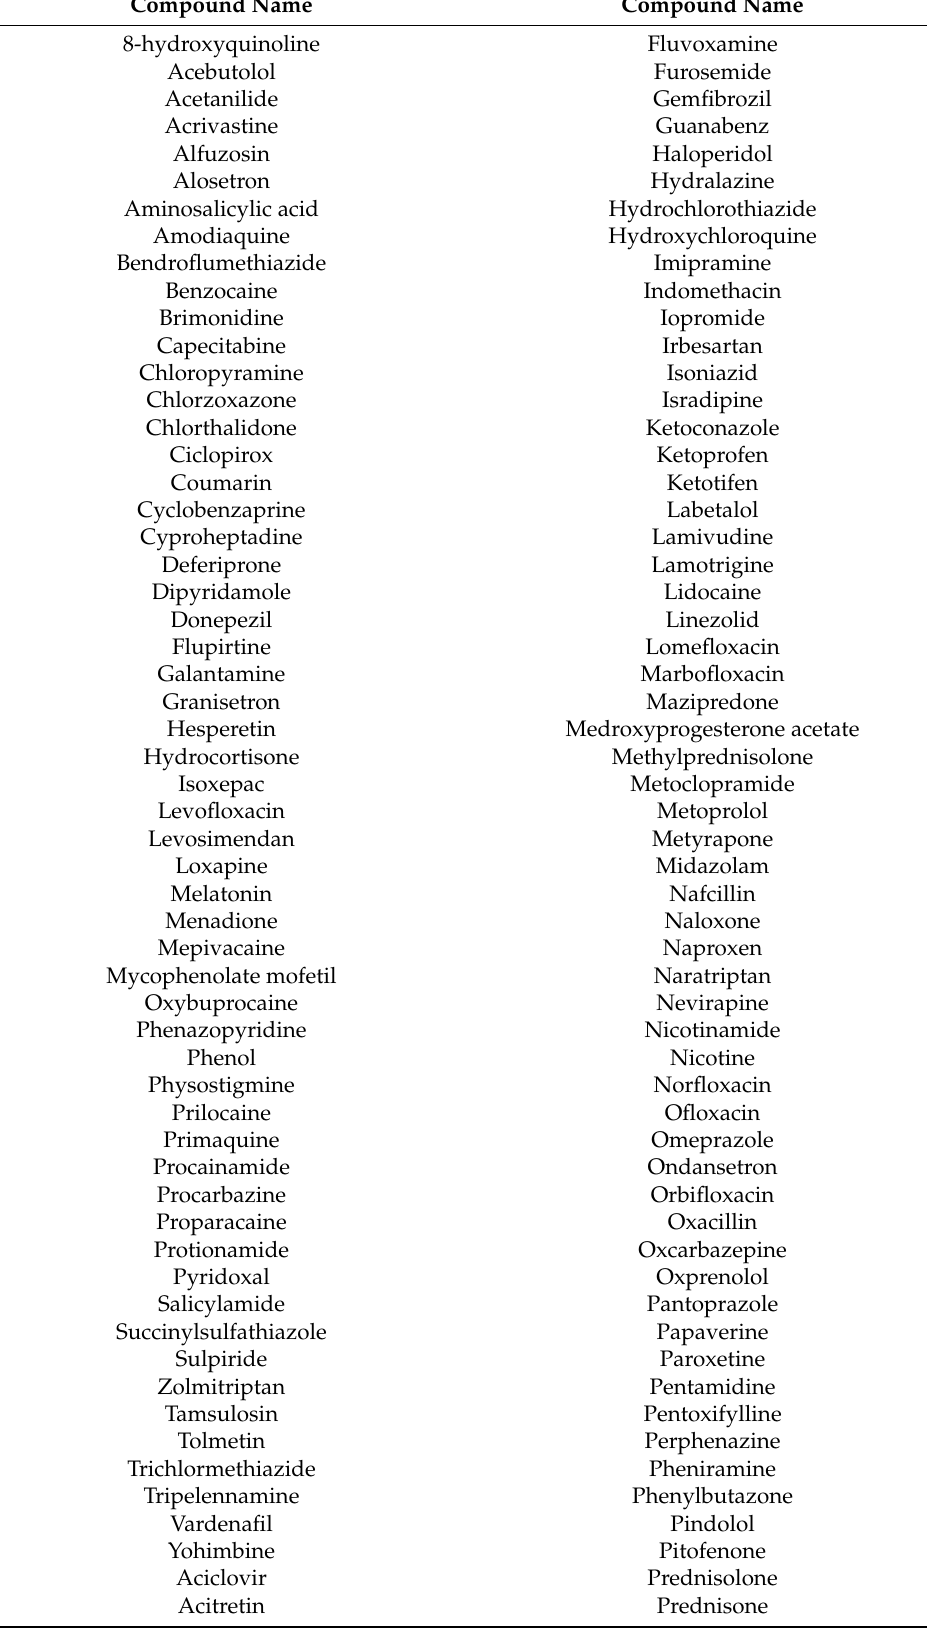
Table 1. List of the 228 investigated